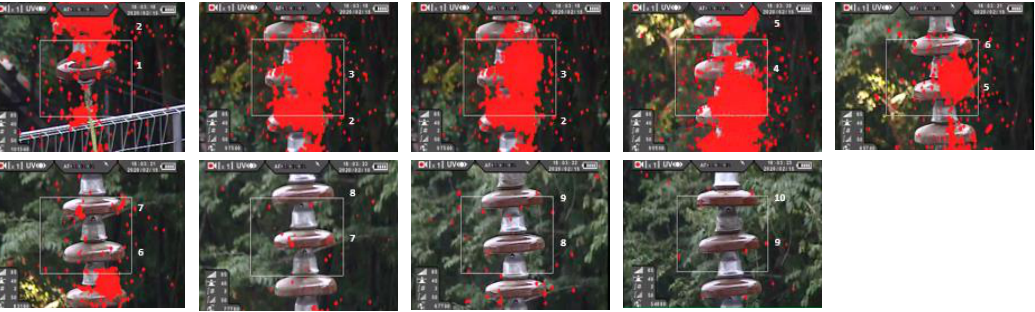
Figure 3. UV connection between the cup-and-pin insulators that had reached 60% of string length.